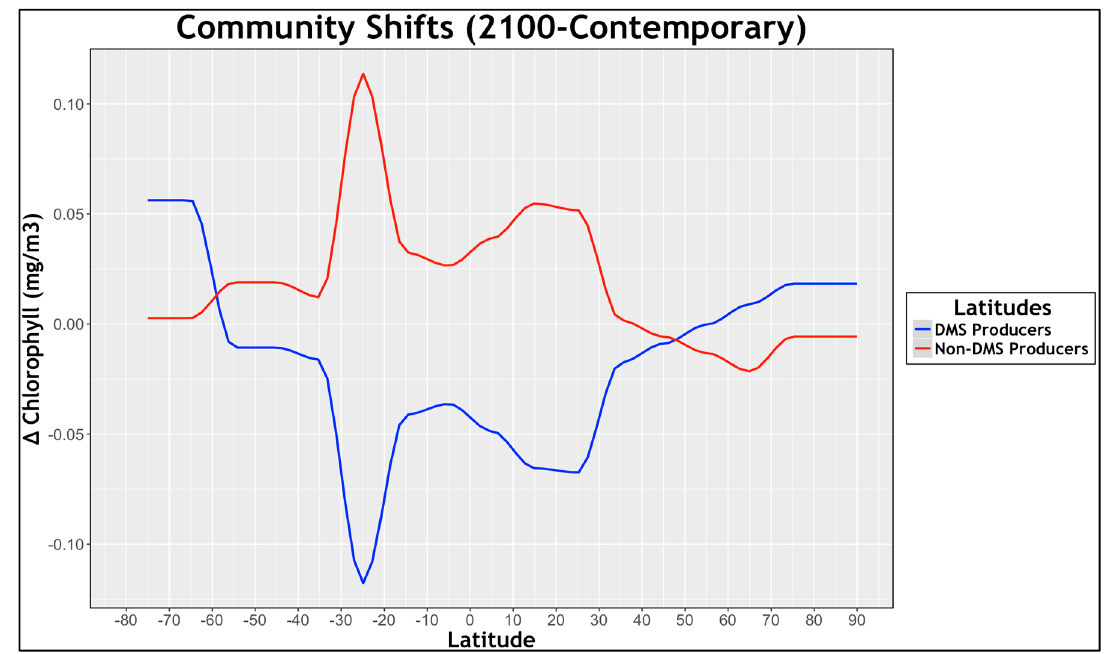
Figure 2. Change in phytoplankton concentration (mg Chl. m − 3 ) at each latitude between the end of century (under an RCP8.5 scenario) and the modern day. Included are non-DMS producers (cyanobacteria, diatoms) (red) and DMS producers ( Phaeocystis , coccolithophores, dinoflagellate et al. group) (blue).